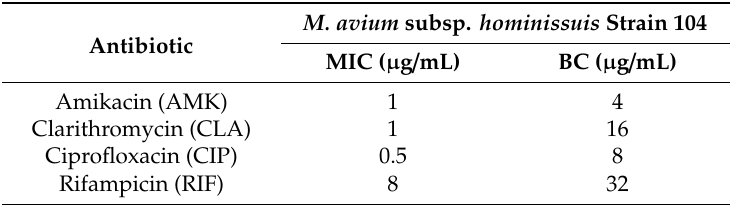
Table 2. MAH104 susceptibility to antibiotics.